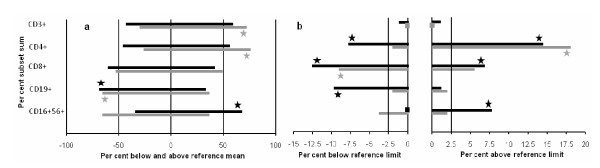
Shifts in percentage distribution of lymphocyte subsets in probands (P), with idiopathic parkinsonism, and their spouses (Ps) compared with reference range (a) mean and (b) its lower and upper reference limits. In P (black bar) and Ps (grey bar), significant differences are denoted by black star and grey star, no subject outside reference limit by black square and grey square.In (b), more than the 2.5% expected had CD4+ (in P), CD8+ (P & Ps) and CD19+ (P) below lower limit (exact binomial test: p ≤ 0.01 in each case), and CD4+ (P & Ps), CD8+ (P) and CD16+56+ (P) above upper limit (p ≤ 0.02).